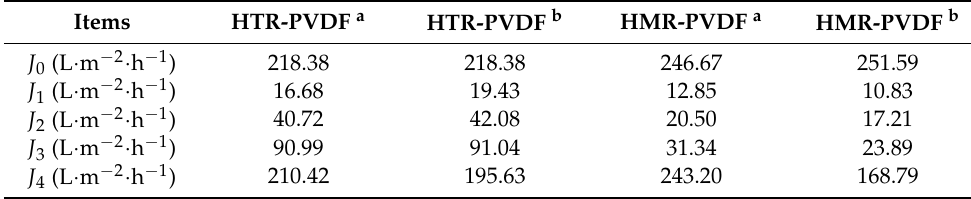
HTR-PVDF a and HTR-PVDF b : immersed the HTR-PVDF membrane in critic acid (20 min) + NaClO (20 min) and NaClO (20 min) + critic acid (20 min), respectively; HMR-PVDF a and HMR-PVDF b : immersed the HMR-PVDF membrane in critic acid (60 min) + NaClO (60 min) and NaClO (60 min) + critic acid (60 min), respectively.